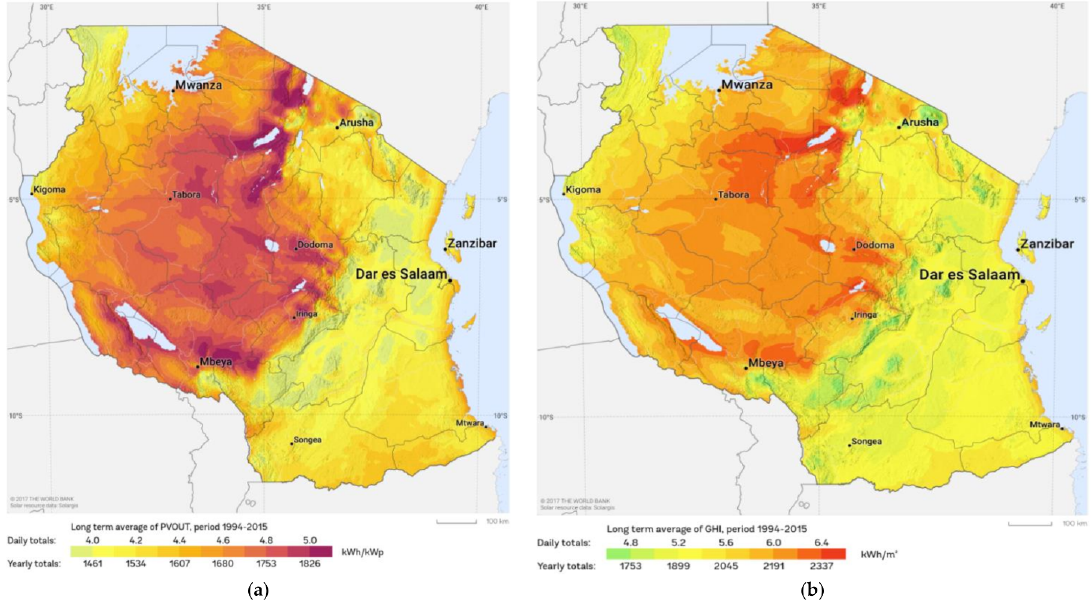
Figure 2. ( a ) Average daily/yearly sum of global horizontal irradiation (GHI); ( b ) Estimated average daily/yearly sum of electricity generation capacity of solar PV generation of Tanzania